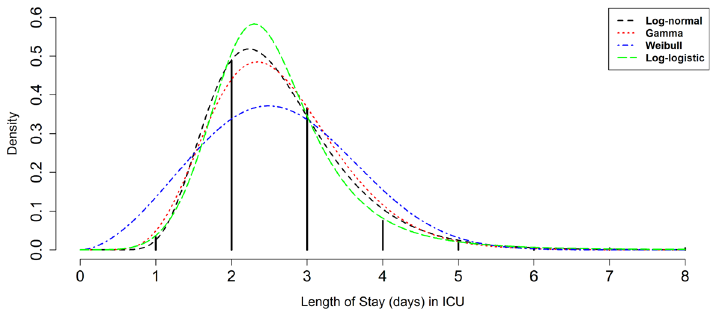
Figure 2. Length of Stay (LOS) in the ICU after operation based on empirical LOS distribution and fitted parametric distributions.